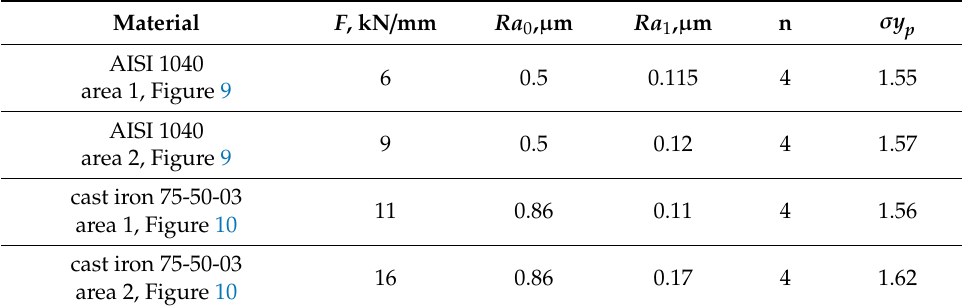
Table 2. Results of the burnishing experiments analysis (Figures 9 and 10)